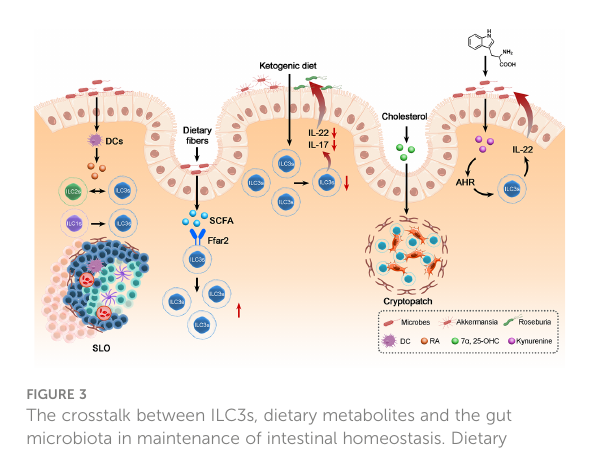
FIGURE 3 The crosstalk between ILC3s, dietary metabolites and the gut microbiota in maintenance of intestinal homeostasis. Dietary metabolites derived from microbes can regulate the biology of ILC3s: Including modulates the frequency of ILC3s, the conversion between ILC3 and ILC1 or ILC2 and the development of SLO, thereby affecting the balance of gut immunity and thus the biology of gut microbes and the homeostasis of